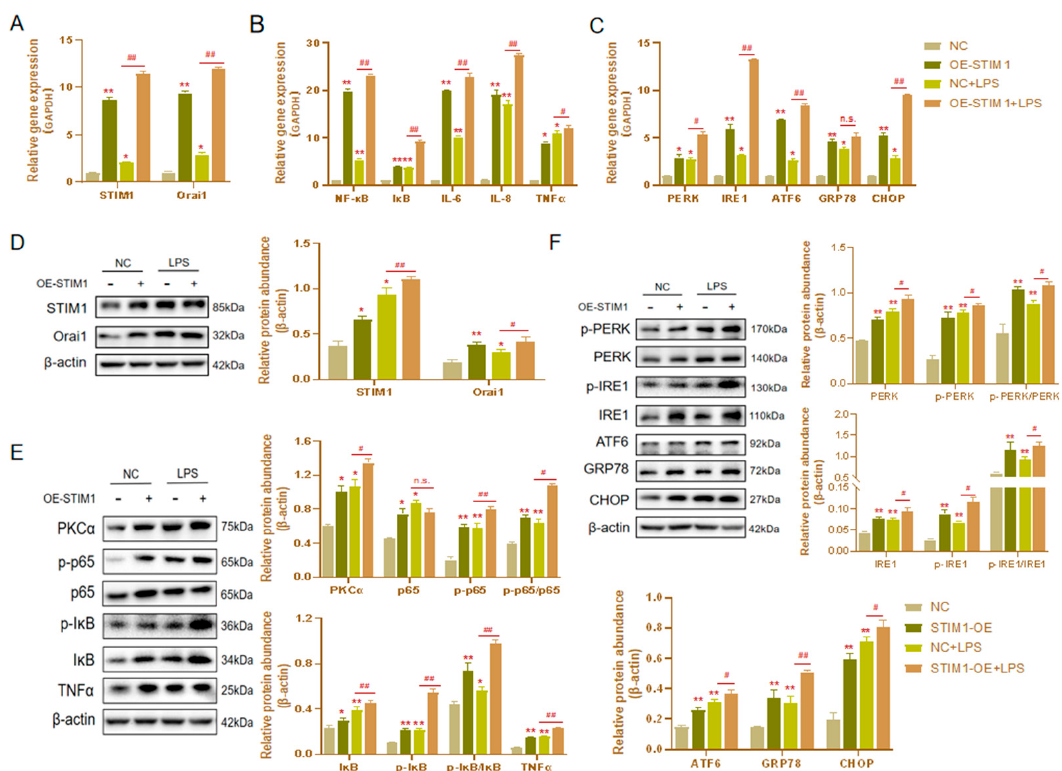
Figure 4. Effects of STIM1 overexpression on LPS-induced inflammation and endoplasmic reticu- lum stress (ERS) in BHEC. Treatments: BHEC were transfected with overexpressed plasmids and cultured for 48 h. NC, transfected blank plasmid cultured for 48 h without LPS treatment; OE- STIM1, BHEC transfected with overexpressed STIM1 plasmids that were cultured for 48 h without LPS treatment; LPS, transfected blank plasmids cultured for 48 h, then treated with 16 μ g/mL LPS for 1 h; OE-STIM1 + LPS, BHEC transfected with overexpressed STIM1 plasmids that were cultured for 48 h and then treated with 16 μ g/mL LPS for 1 h. Gene expression of STIM1/Orai1 ( A ), inflam- matory cytokines (NF- κ B, I κ B, IL-6, IL-8, and TNF- α ) ( B ), and ERS-related genes (PERK, IRE1, ATF6, GRP78, and CHOP) ( C ) in BHEC. The protein abundance of STIM1/Orai1 ( D ), inflammatory cyto- kines (PKC α , p65, p-p65, I κ B, p-I κ B, and TNF α ) ( E ), and ERS-related genes (PERK, IRE1, ATF6, GRP78, and CHOP) ( F ) was normalized to the abundance of β -actin. The results are presented as the means ± SEM. * p < 0.05, ** p < 0.01 indicate that the LPS groups and the OE-STIM1 groups were significantly different from control group. # p < 0.05, ## p < 0.01 indicates the significant difference between the OE-STIM1 + LPS groups and the NC + LPS groups; n.s. indicates no difference between the two